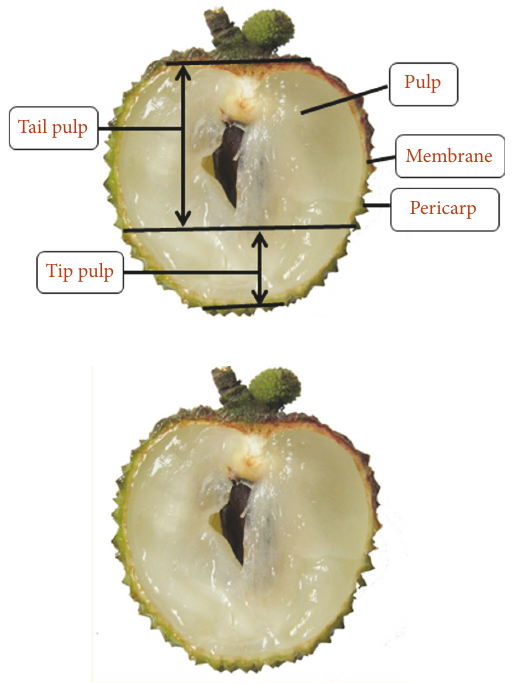
Figure 1: The schematic diagram of different part in Feizixiao